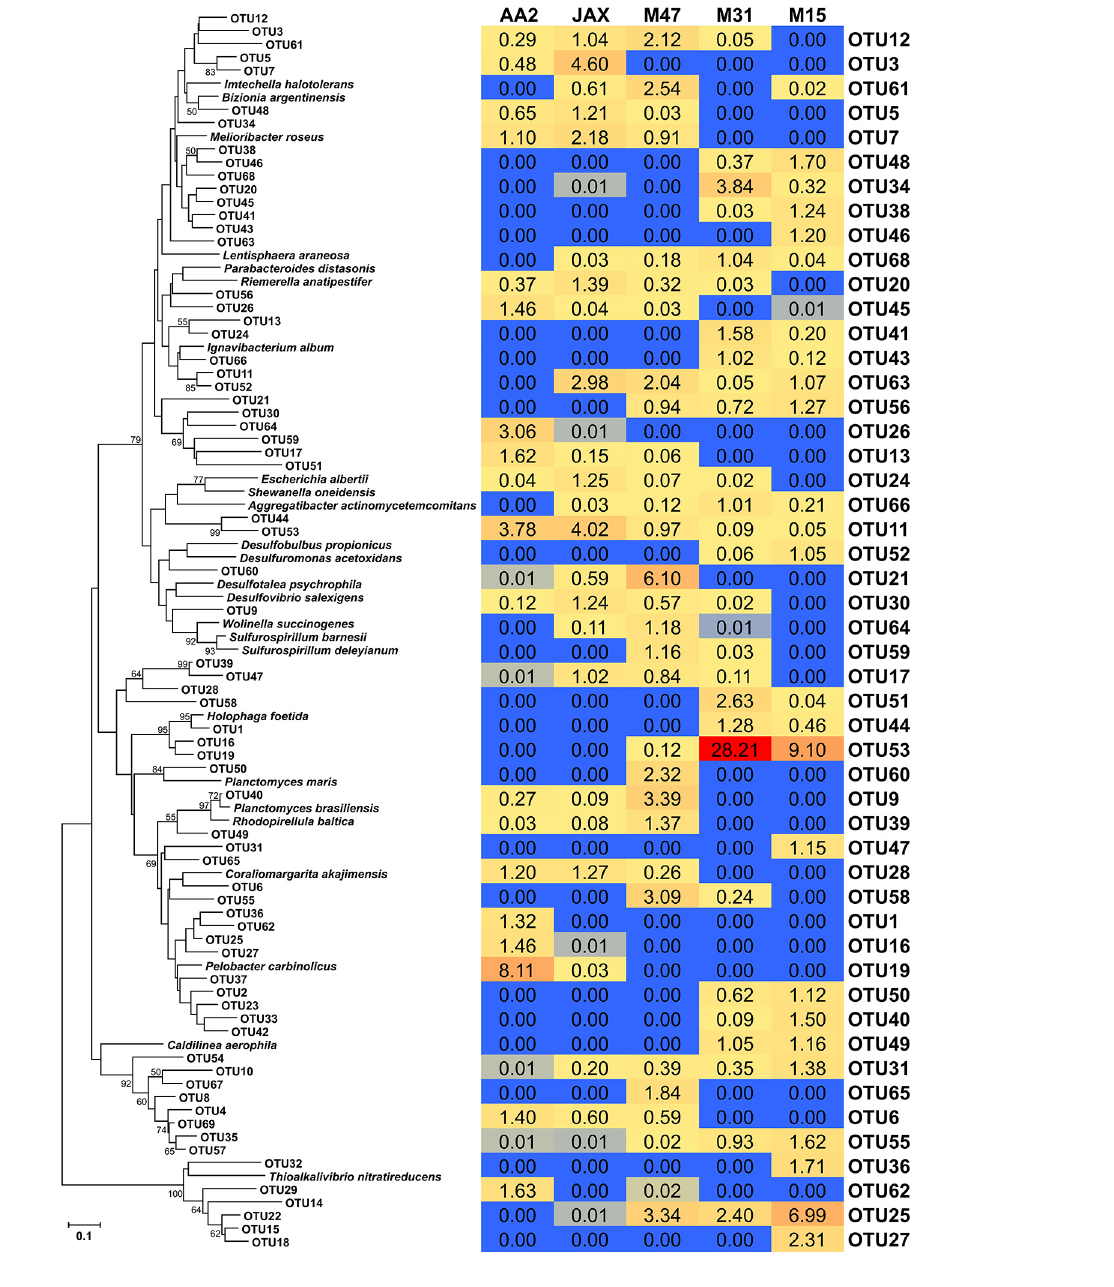
sequences and bootstrap analysis with 1000 replicates used to estimate confidence. Bootstrap values of > 50% were listed in the tree. The heat map was constructed in Microsoft Excel based on the percent relative of each OTU in each sediment